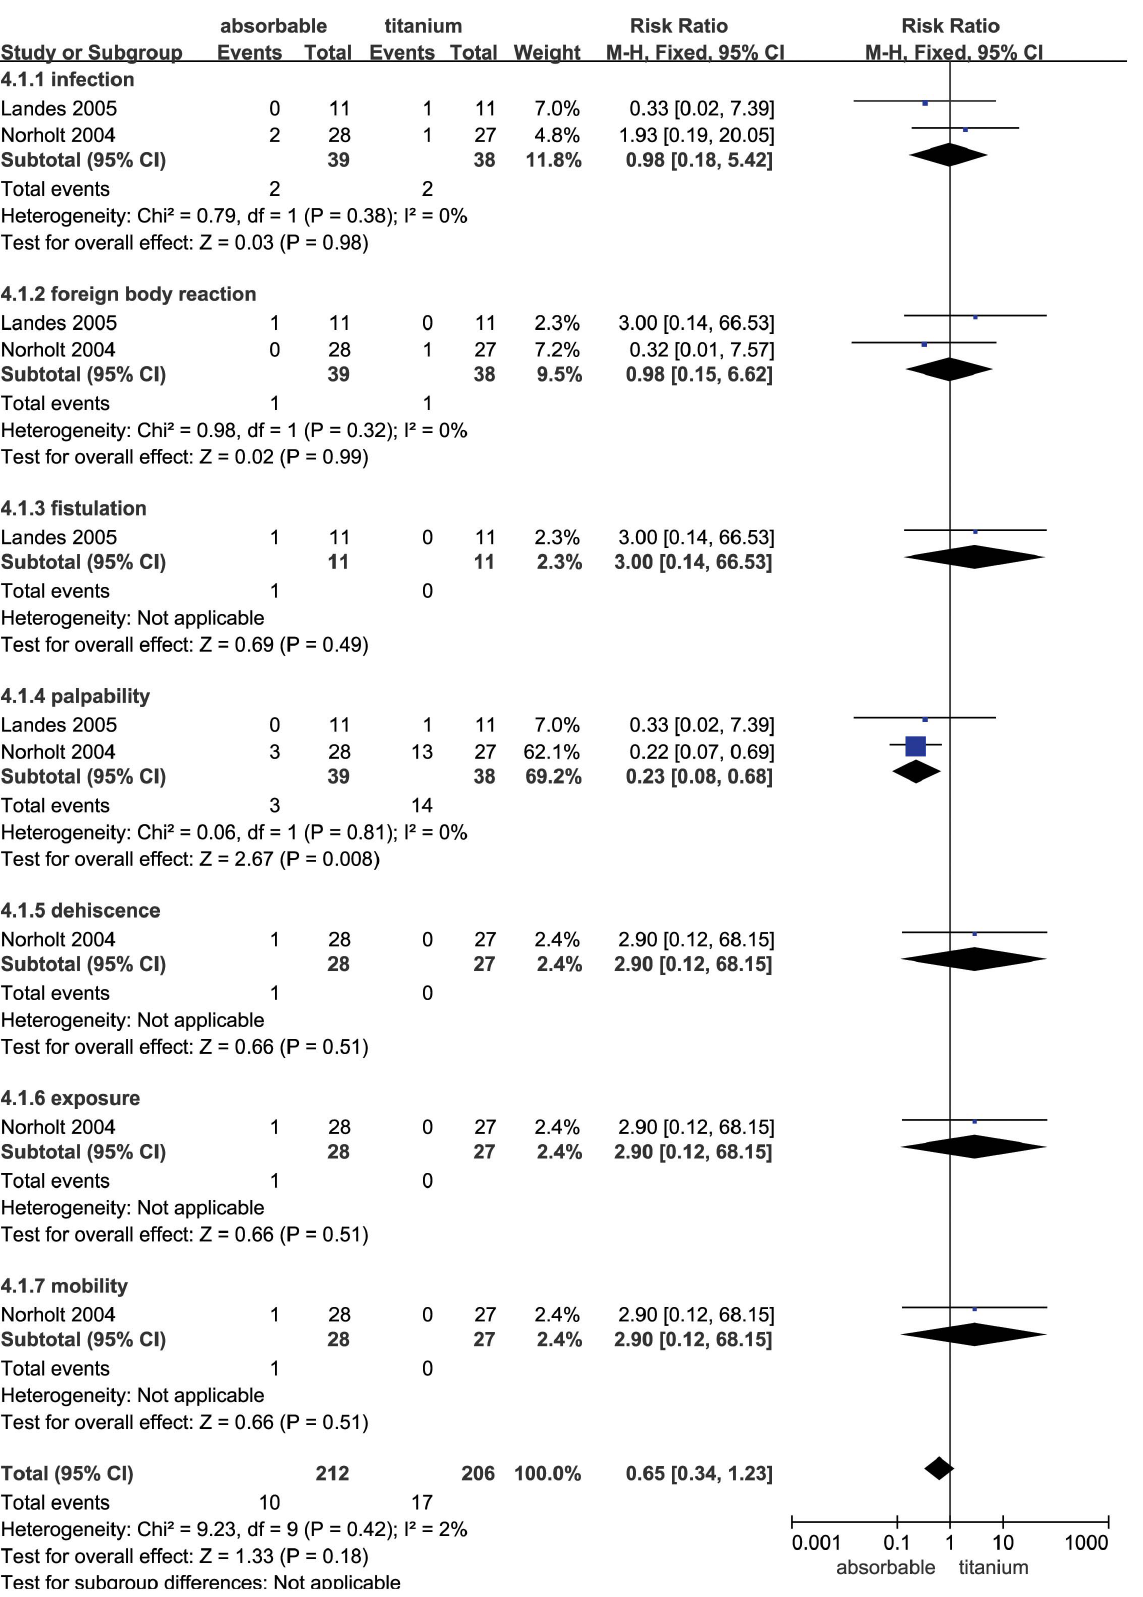
Figure 6. Forest plot of trials of absorbable fixation versus titanium examining the effect on relative risk of complications in Le Fort I. See Figure 2 legend for expansion of abbreviations.